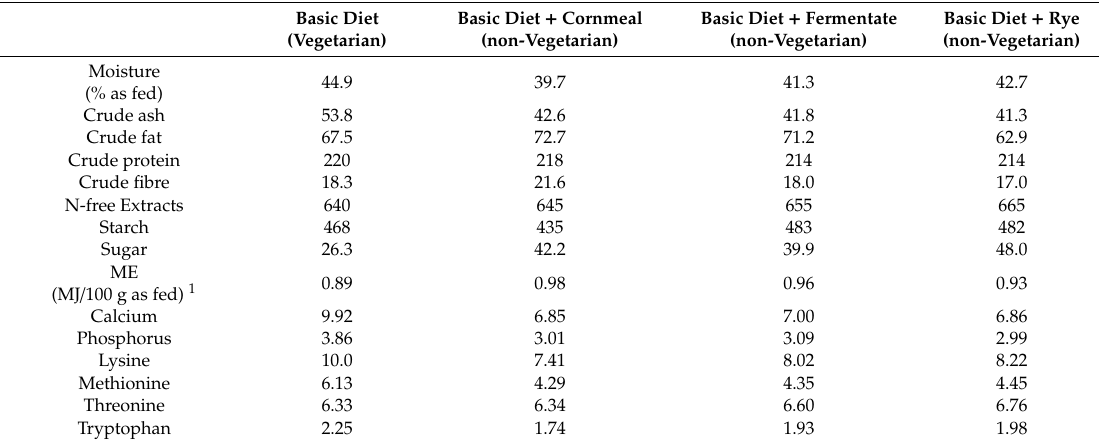
Table 2. Chemical composition (in g / kg dry matter if not other stated) of the vegetarian diet (basic diet) and the vegetarian diet supplemented with feather meal as well as either cornmeal (basic diet